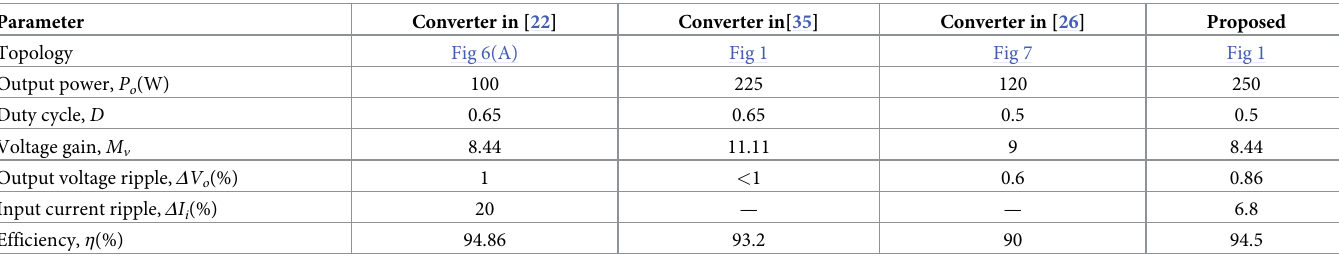
Table 2. Comparison between the developed converter and some other converters applicable in PV